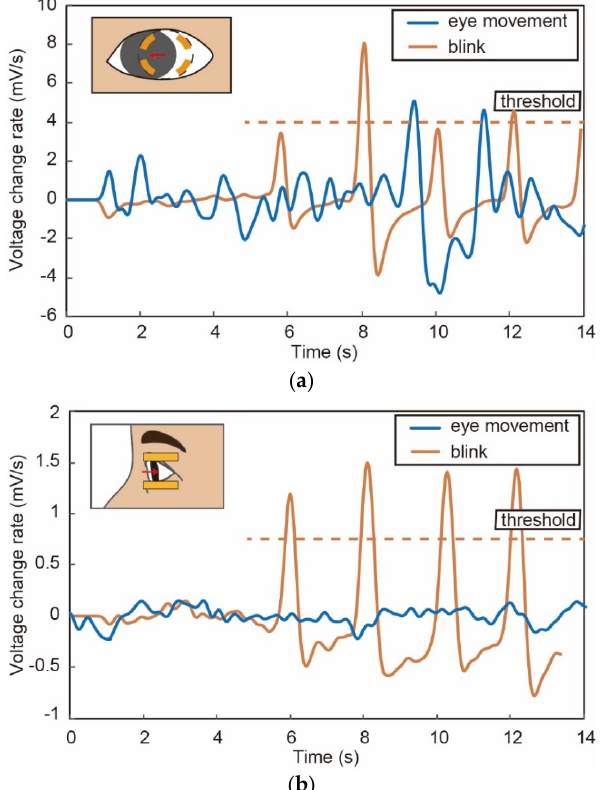
Figure 10. The sensor outputs when the subject moves the eye and blinks while moving the eye in case of ( a ) eyeglasses type device and ( b ) smart glass device.